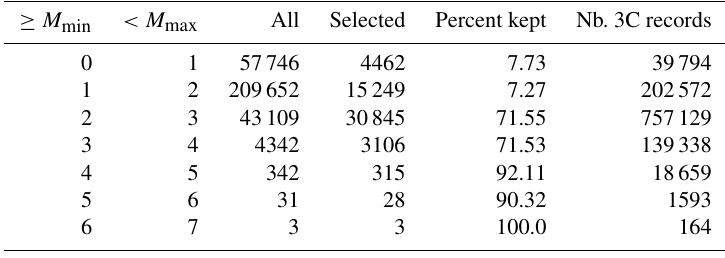
Table 1. Final data selection. “All” indicates the total number of earthquakes in the INGV bulletin in the time period between 1 January 2005 and 31 January 2020, “Selected” and “Percent kept” refer to the earthquakes, and “Nb. 3C records” refers to the waveform traces included in the dataset.